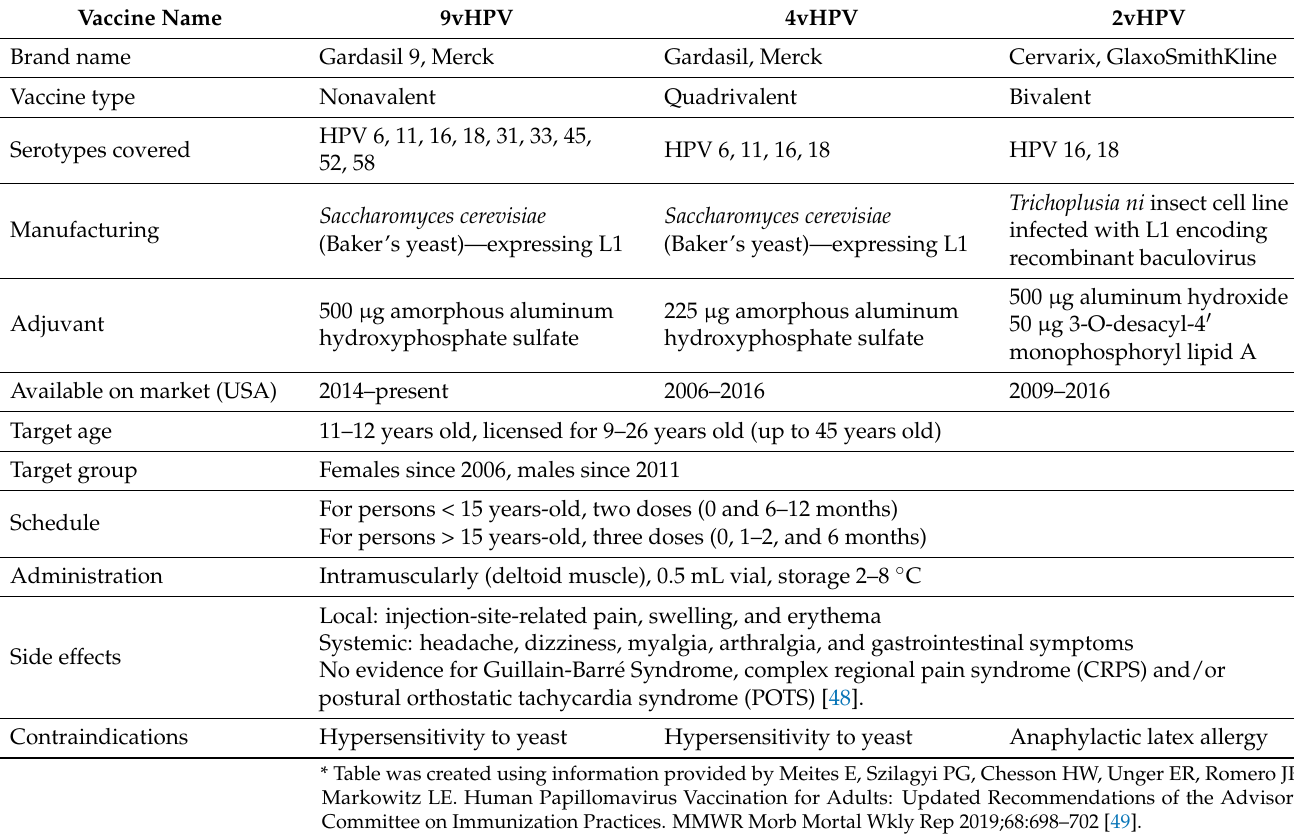
Table 2. The most recent HPV prophylactic vaccines recommended by the Centers for Disease Control and Prevention (CDC) Advisory Committee on Immunization Practices (ACIP)